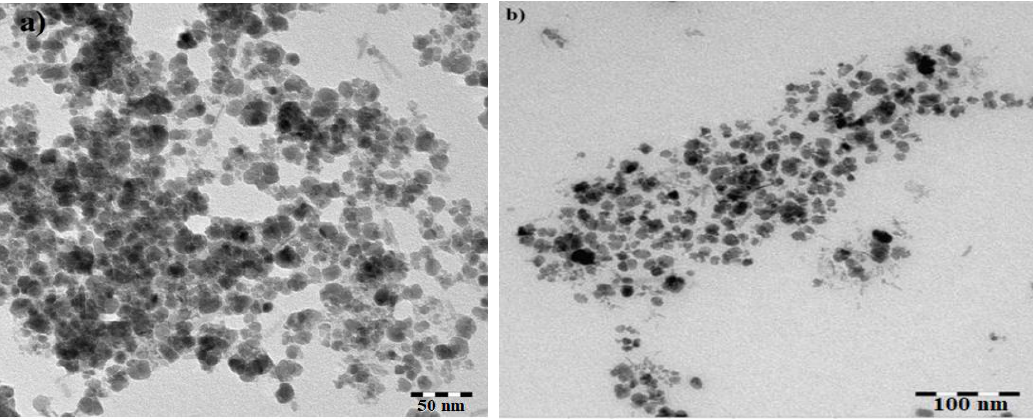
Figure 4. TEM micrographs of magnetite nanomaterials coated by ( a ) M. aurea extract (MAE-MNMs) and b ) O. baccatus extract (OBE-MNMs).